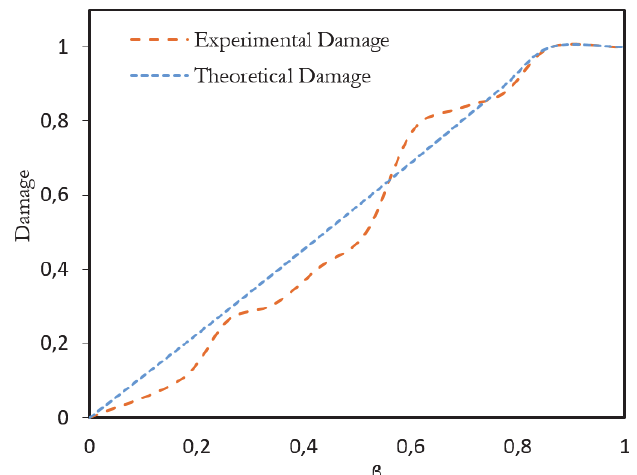
Figure 6: Theoretical and experimental damage as a function of the life